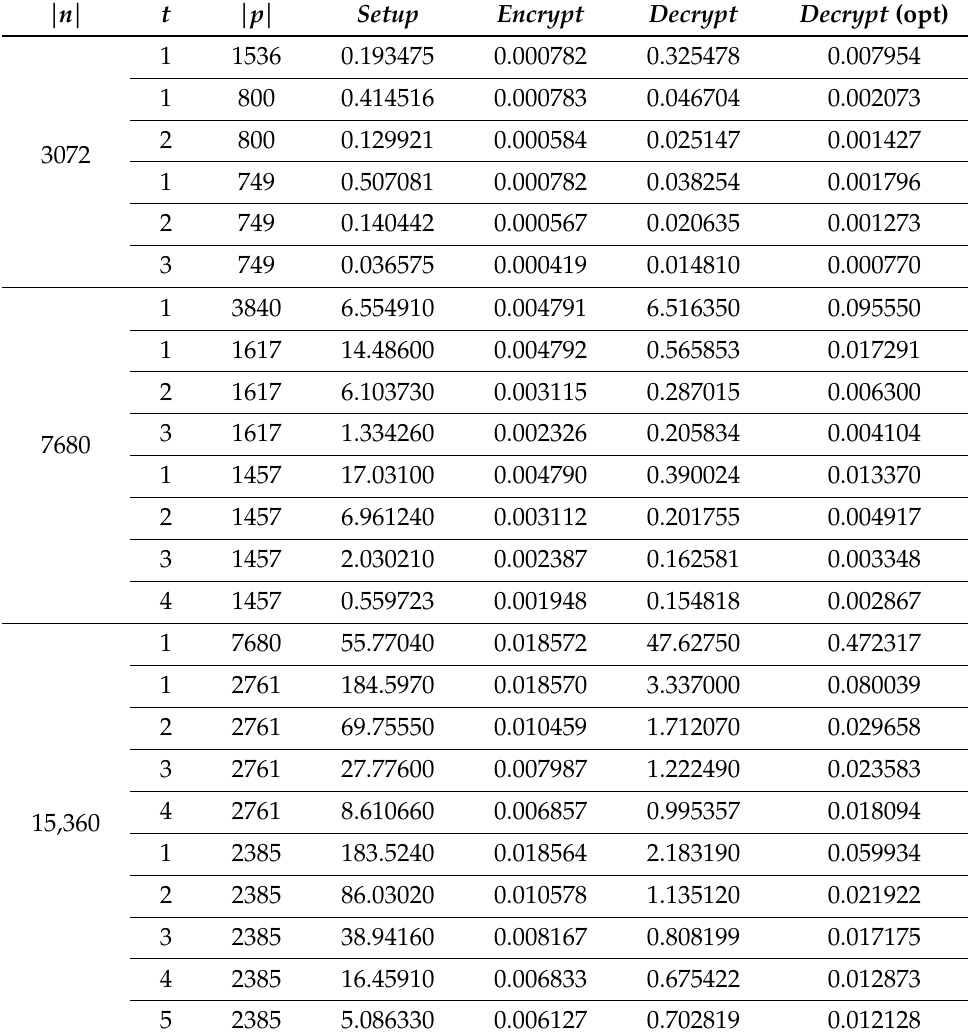
Table 6. Running